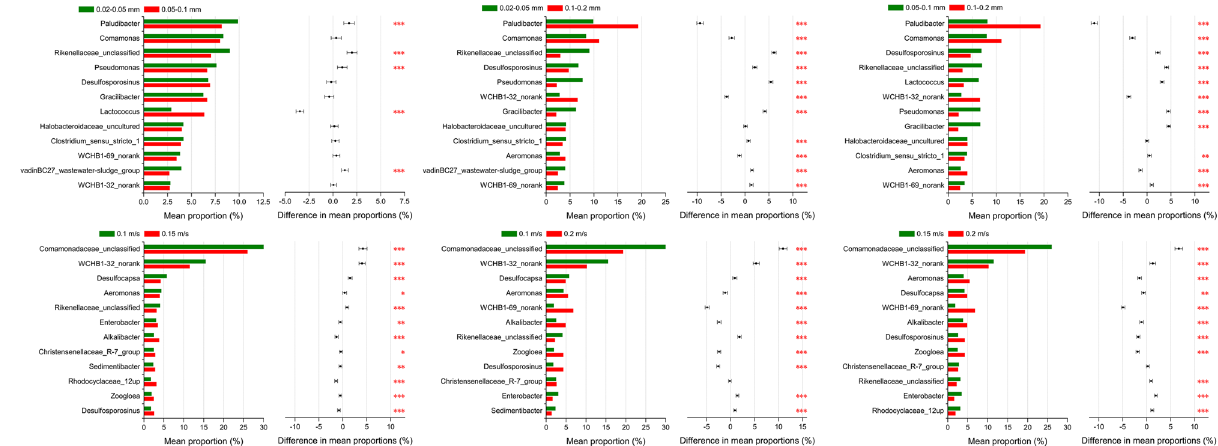
Figure 5. Chi-square test of the species abundance at the genus-level for sediments under different experimental conditions (0.01 < * p ≤ 0.05; 0.001 < ** p ≤ 0.01; *** p ≤